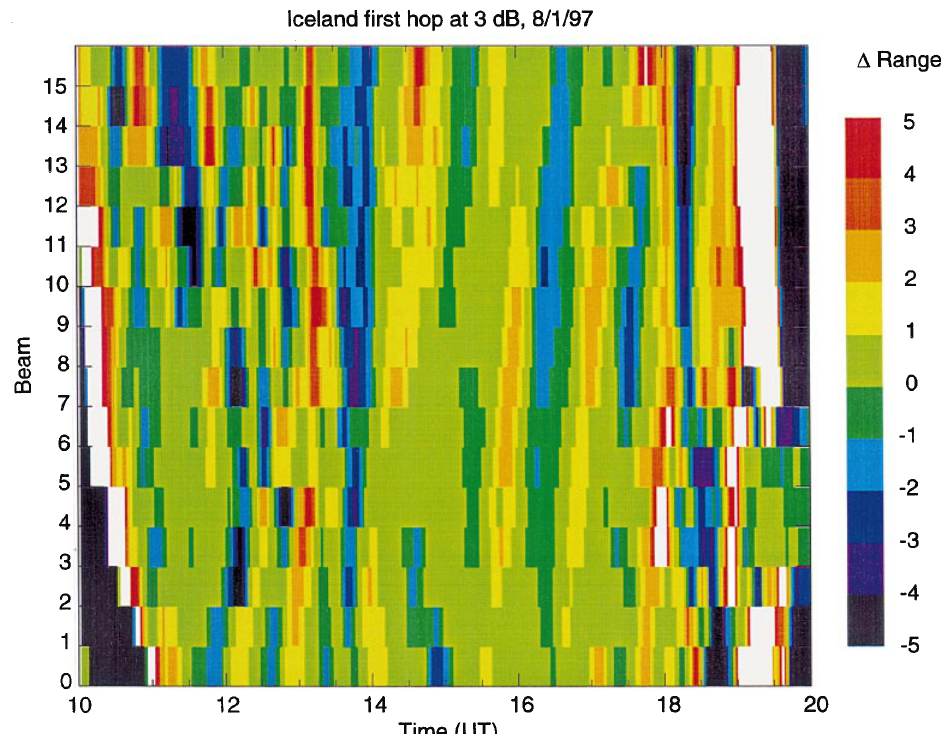
Fig. 5. Perturbations in the Ice- land first returns after removing the diurnal variation for 8 January, 1997 across all 16